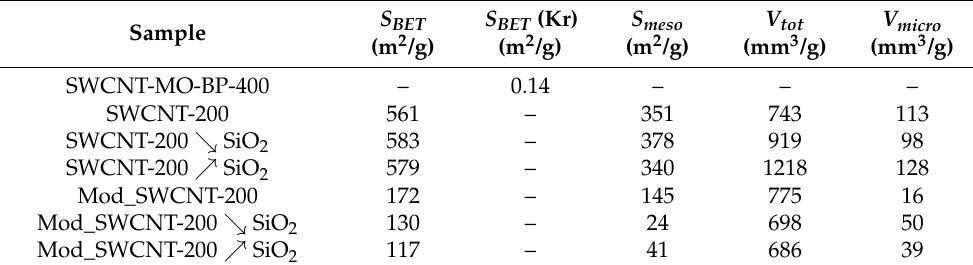
Table 7. Results of textural